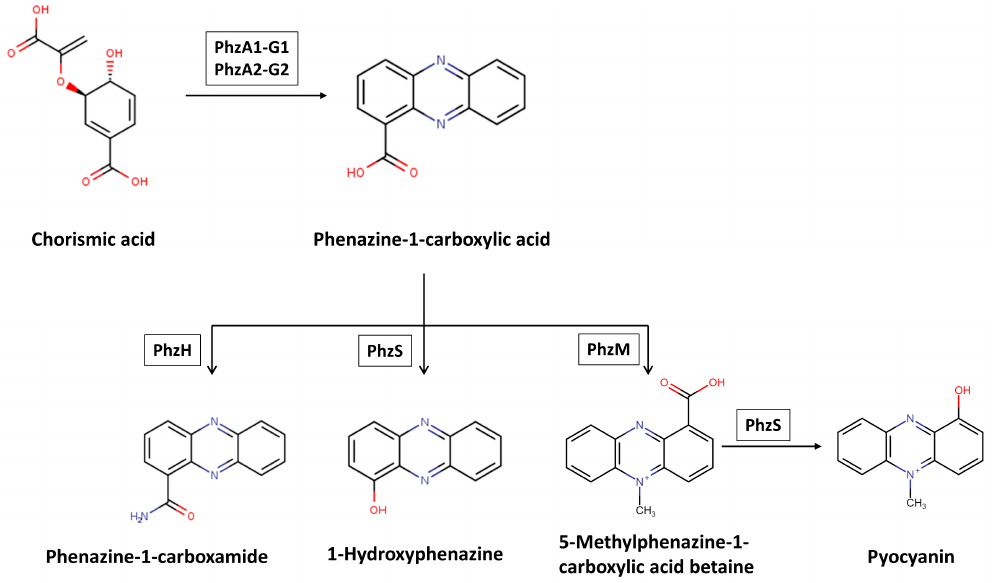
Figure 4. Phenazine pathway in P. aeruginosa.